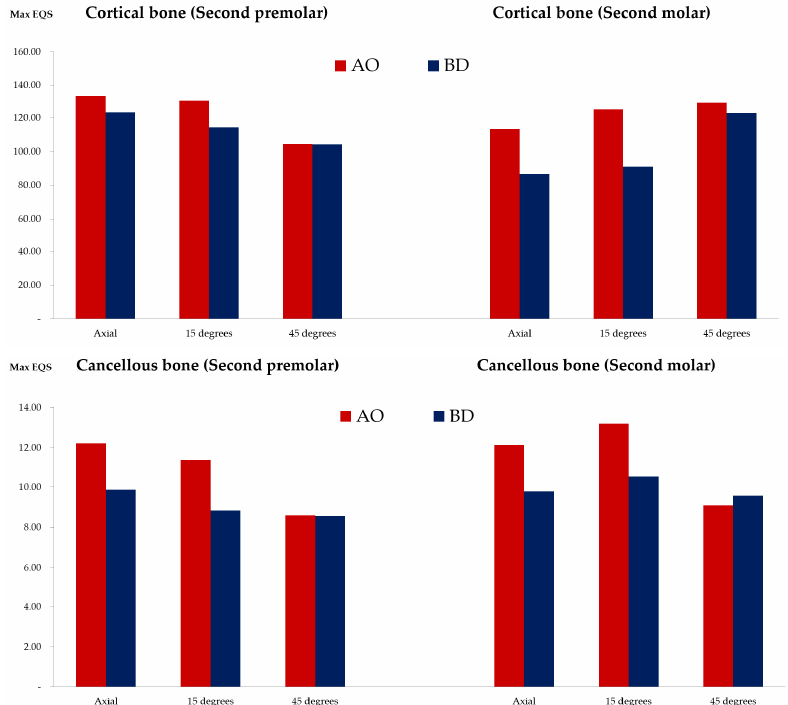
Figure 12. Average stress distribution from the inner surface of the cortical and cancellous bone in the second premolar and second molar areas.